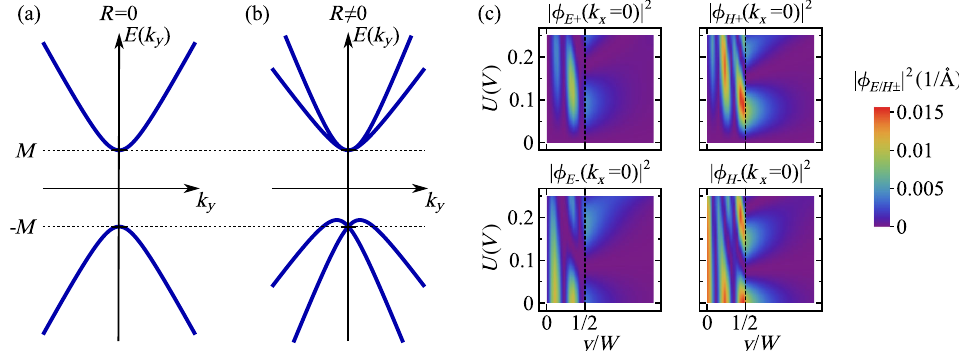
¼ 0 for the 2D quantum-well Hamiltonian (a) without Rashba coupling and (b) with Rashba coupling. FIG. 3. Band dispersion at k x The important distinction between the two cases is that there are generically two distinct wave vectors yielding the same energy in (a) but four in (b). Upon gate defining a wire, confined wave functions are then built from additional harmonics when Rashba coupling is present. The added harmonics result in oscillatory behavior of the confined wave functions that, in turn, produce oscillations in physical quantities for the gate-defined wire such as the effective g factors and characteristic Rashba spin-orbit energies. (c) Evolution ð k ¼ 0 ; y Þj 2 for the n ¼ 5 band as a function of the voltage drop U . Data correspond to a of the probability amplitudes j (cid:2) E=H (cid:6) x d ¼ 70 - (cid:5)A quantum well hosting a wire of width W ¼ 800 (cid:5)A and confinement depth V ¼ 0 : 06 eV , and were obtained numerically as described in Sec. II B. The oscillations in the wave-function tails shown in each plot underlie the oscillatory behavior of physical quantities noted